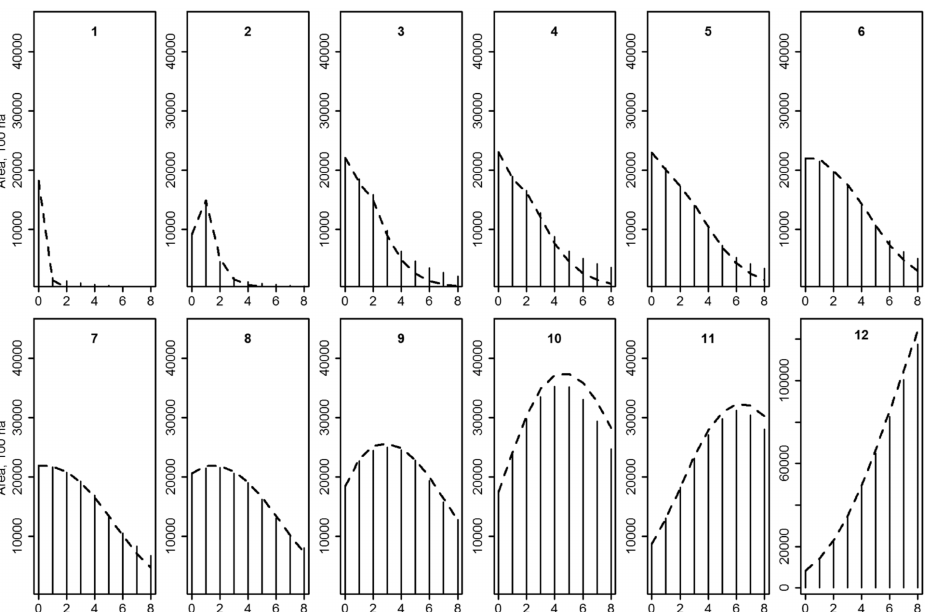
Figure 2. A comparison of Age-Vol (vertical bars) and N-Vol (dashed lines) matrices derived from the permanent plots in the simulations of the natural process. The subplots illustrate the development of the volume class indicated in the plot along the number of simulation steps of 5 years given in the x -axis (step 0 indicates the initial state). Note that the scale of y -axis of the volume class 12 differs from the others.